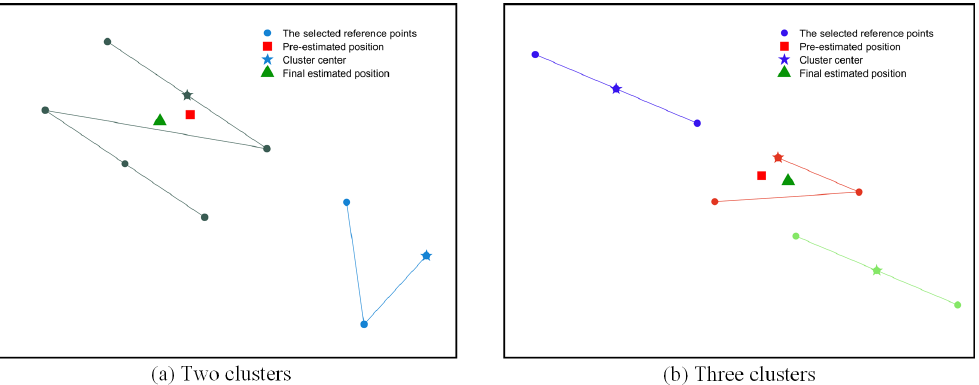
Figure 5. The illustration of selecting optimal sub-cluster by using